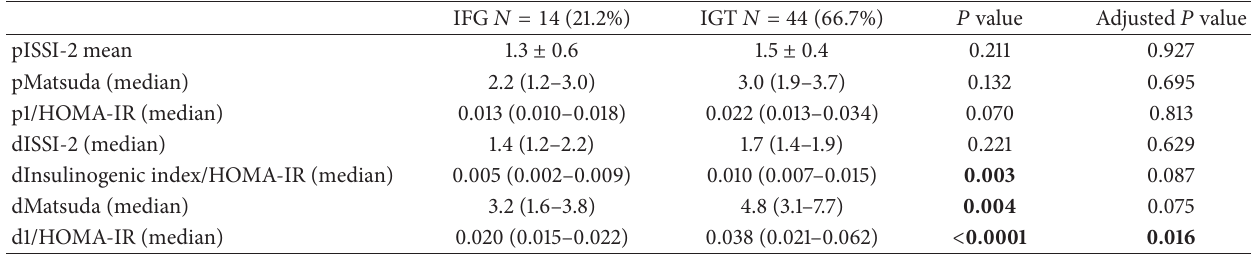
Table 5: Comparison of the beta-cell function and the insulin sensitivity between women with an impaired fasting glucose (IFG) and women with an impaired glucose tolerance (IGT)